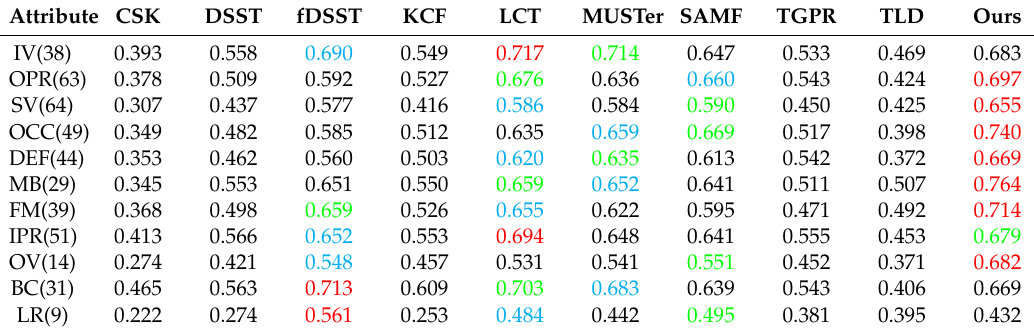
Table 4. Attribute-based analysis of OTB-2015 (mean OP score). The first, second and third highest results are colored red, green and blue,